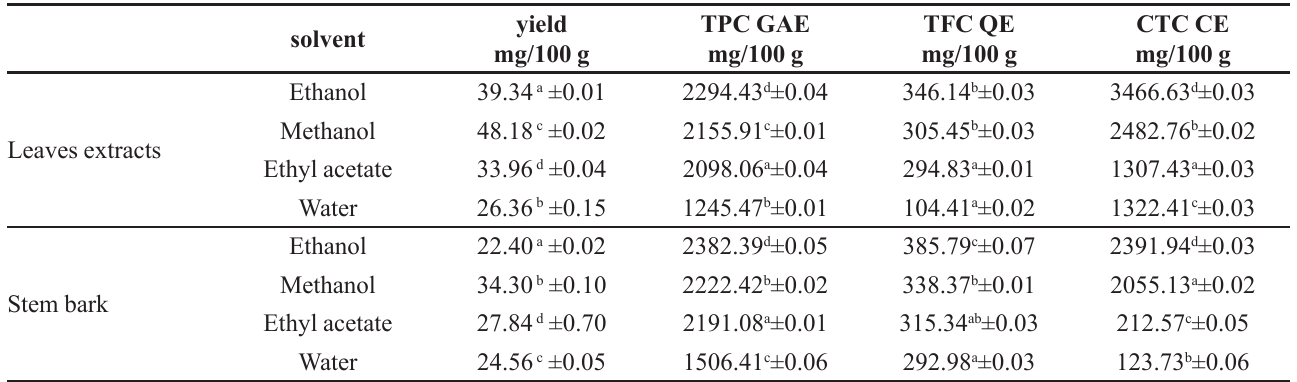
TABLE V - Total phenolic, flavonoids, tannin contents and antioxidant activity of various solvent extracts from Anisophyllea laurina Leaves and stem bark